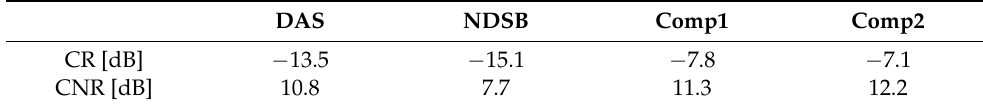
Figure 8. B-mode images of the longitudinal-section carotid artery in 50-dB range. ( a ) DAS image ( b ) NDSB image ( c ) Comp1 image ( d ) Comp2 image. Table 4. Contrast-ratio and Contrast-to-noise ratio for Figure 8.